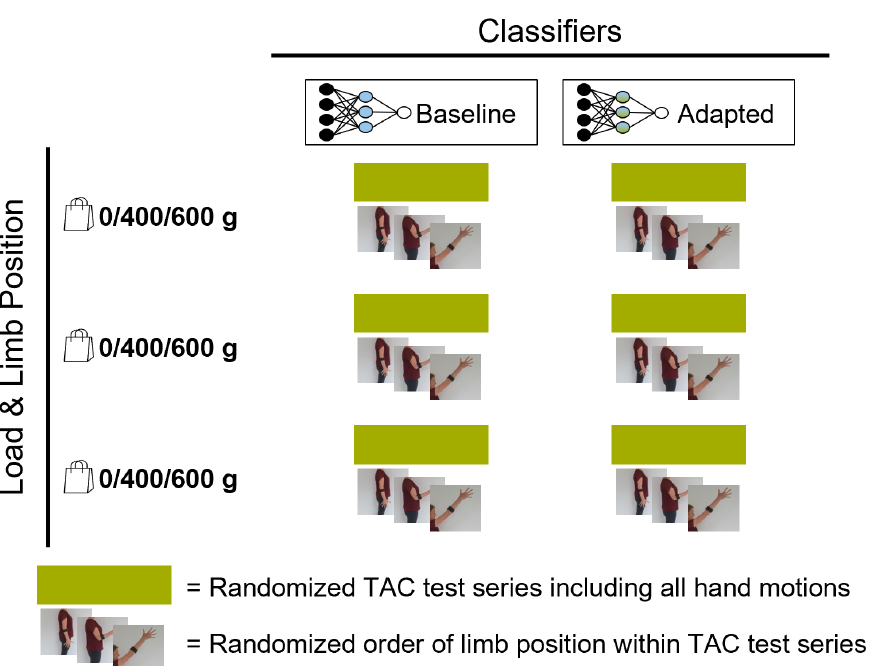
Figure 12. Testing phase procedure. Classifiers (baseline and adapted) were tested in TAC test series three times each, in randomized alternating order. The external load was changed before each pair of TAC test series. Limb position varied for each hand position within the